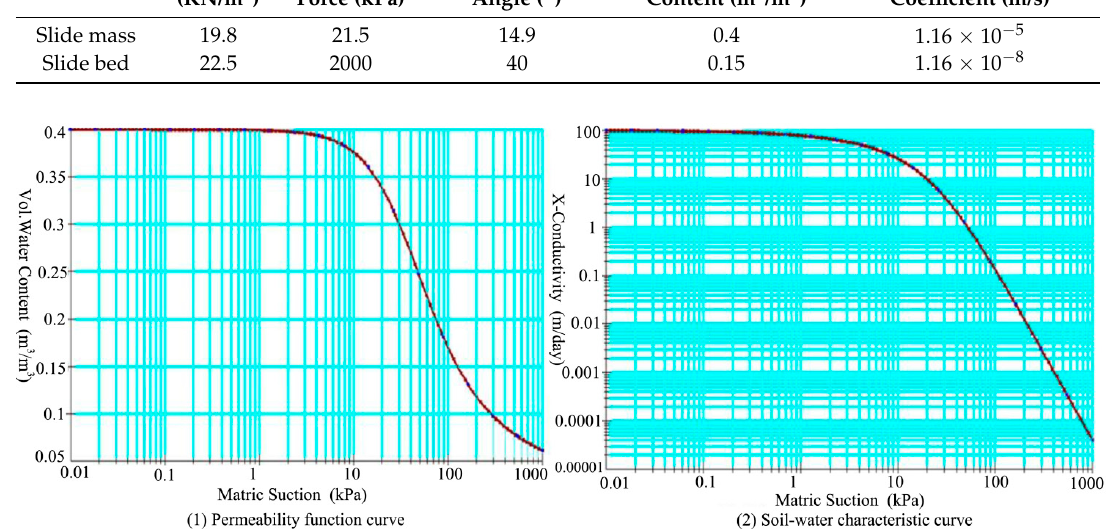
Figure 5. Soil-water characteristic curve and permeability function of the slide mass.